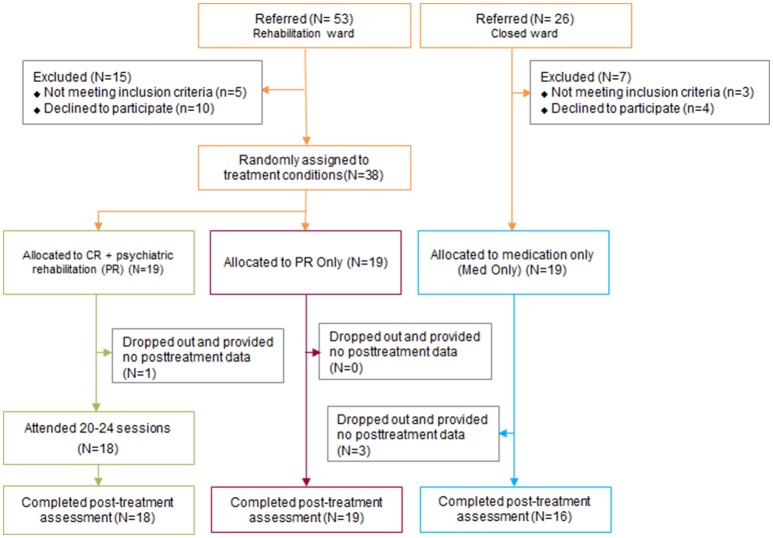
Consolidated standards of reporting trials diagram of the selection of the participants in the study. CR, Cognitive remediation; PR, Psychiatric rehabilitation; TAU, Treatment As Usual.